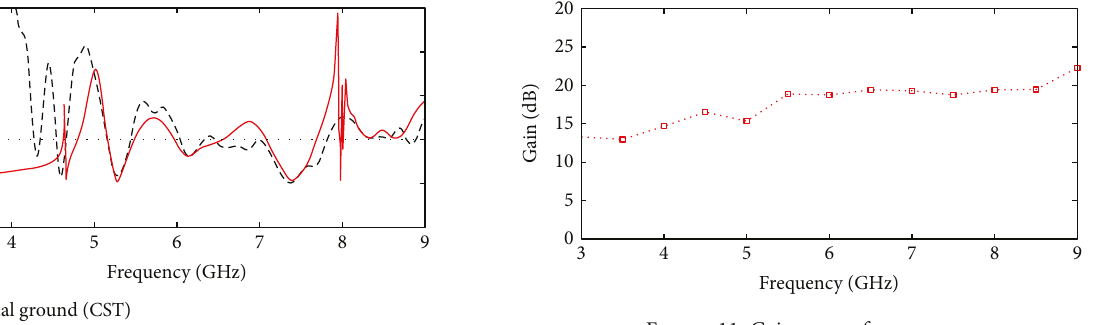
Figure 11: Gain versus